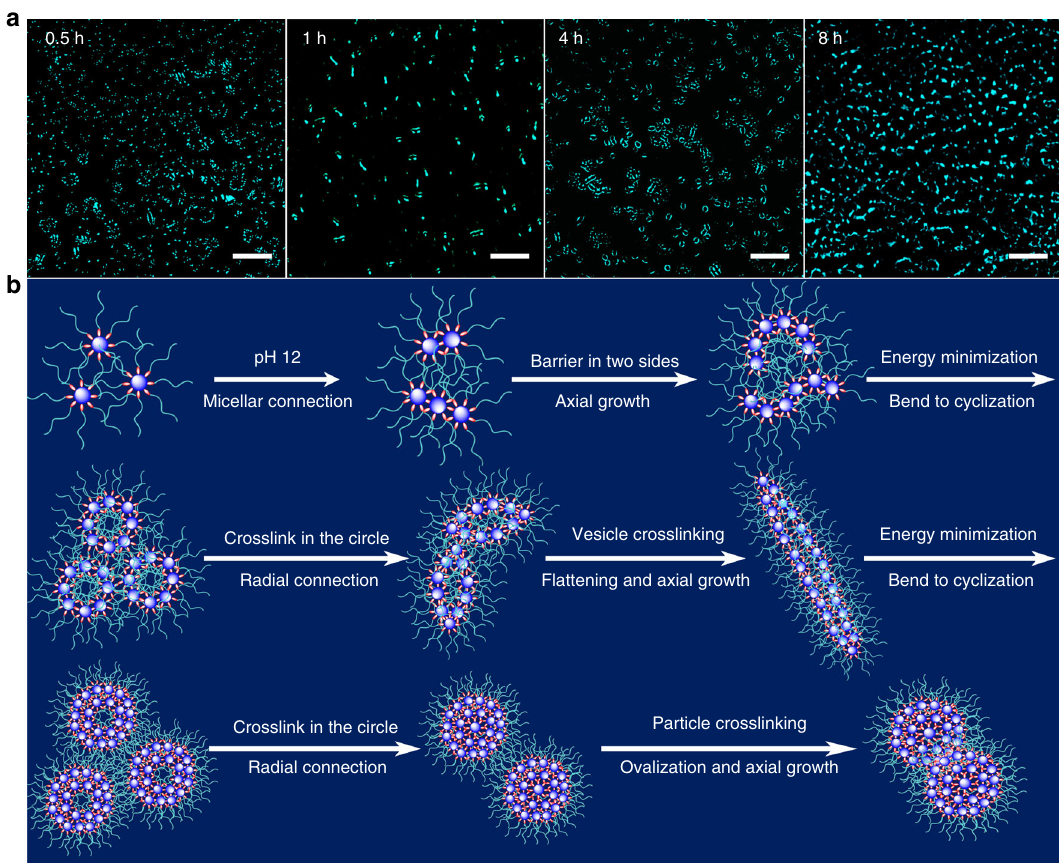
Fig. 8 Hierarchical self-assembly strategy for morphology evolution within the full-scales. a Confocal laser scanning microscopy (CLSM) images of the POSS-SS-(PEG) 8 @TPE-CHO aggregates in pH 12 THF/H 2 O mixtures for various times. Scale bars are 2 μ m. On account of the cage structure of POSS units and propeller shape of TPE-CHO molecules, the POSS-SS-(PEG) 8 @TPE-CHO aggregates could present a little difference of morphology